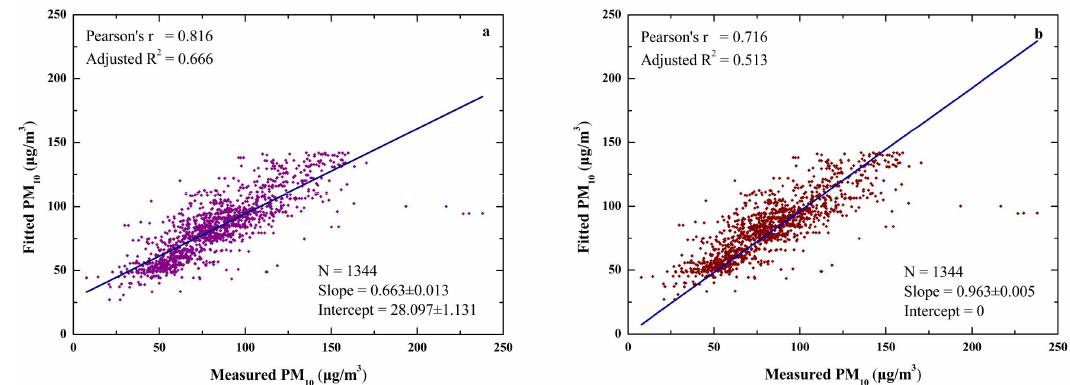
Figure 4. Scatter plot of cross validation for the original GWR model, using conventional linear regression ( a ); and linear regression with intercept fixed at zero ( b ).